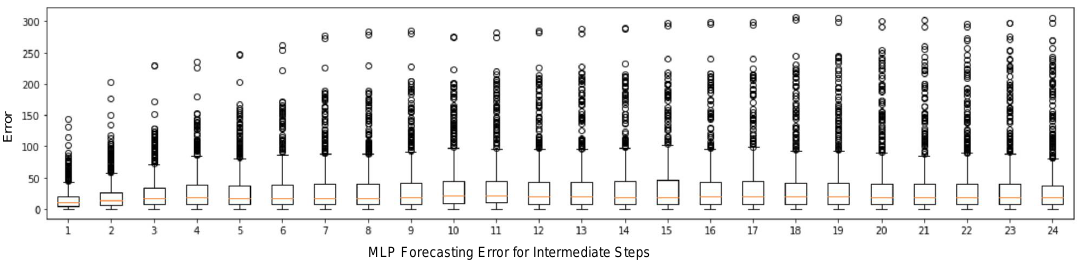
Figure 14. The distribution of absolute error for ARIMA in multi-step forecasting scenario. As it is natural to see, the absolute error increases with the number of steps forward to forecast.